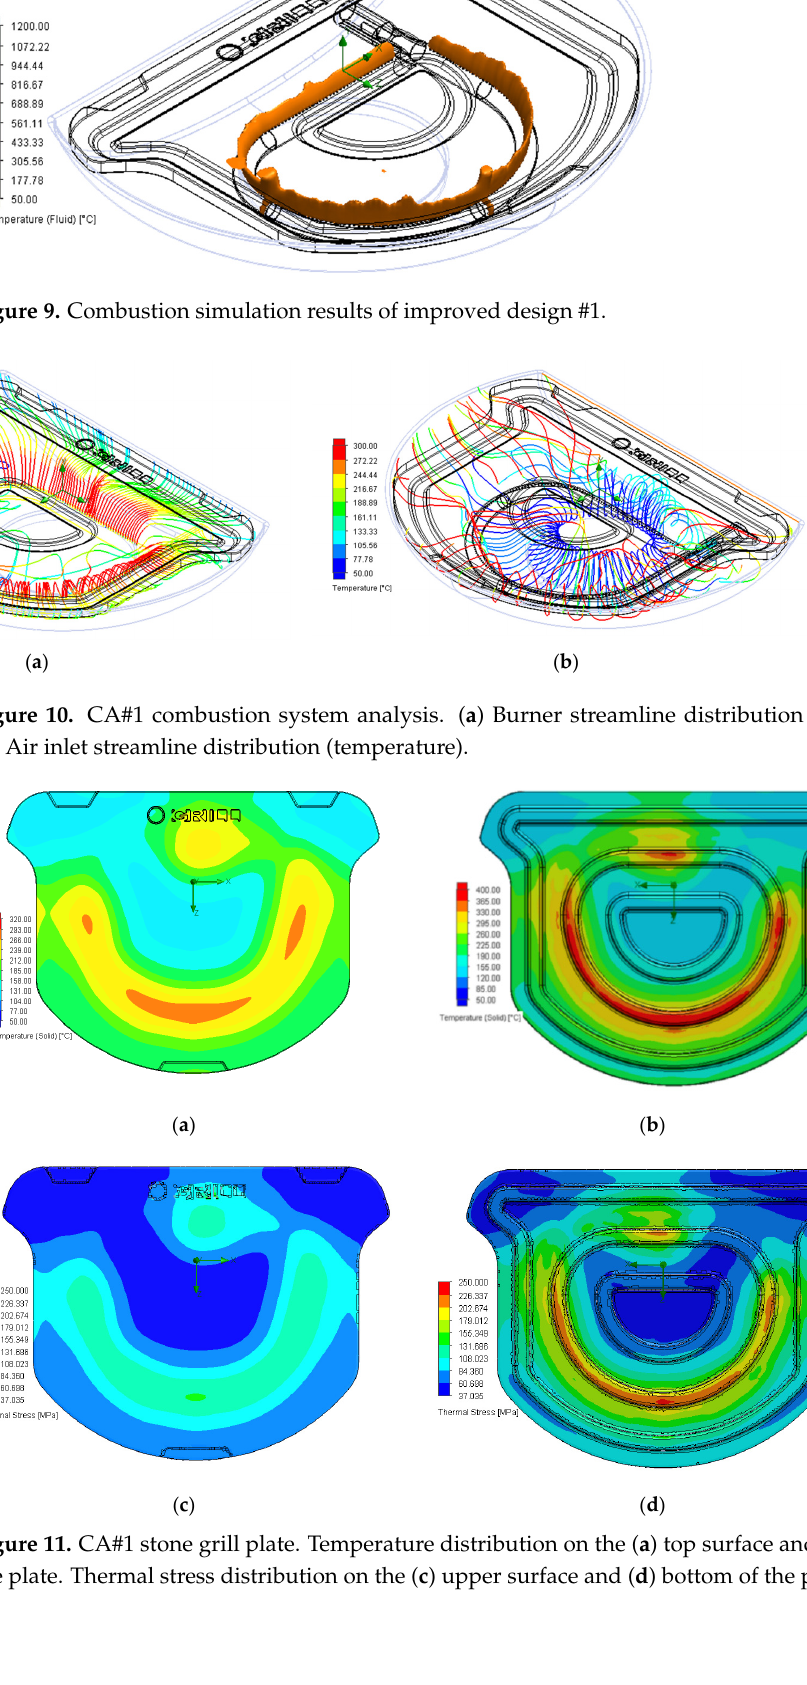
Figure 8. Improved design #1. ( a ) A guiding plate is installed in the original combustion tube; ( b ) Simulated gas analysis diagram of the improved design.